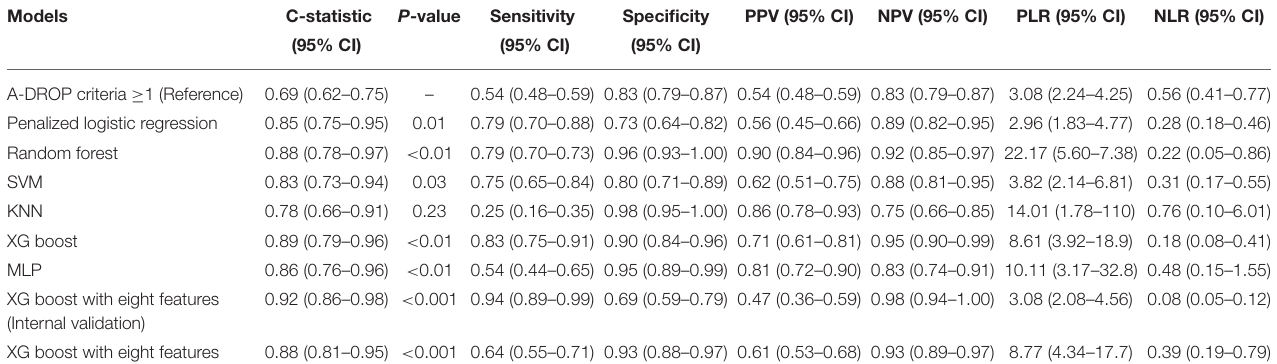
TABLE 3 | The ability of eight machine-learning models and A-DROP as the risk stratification tool. Models